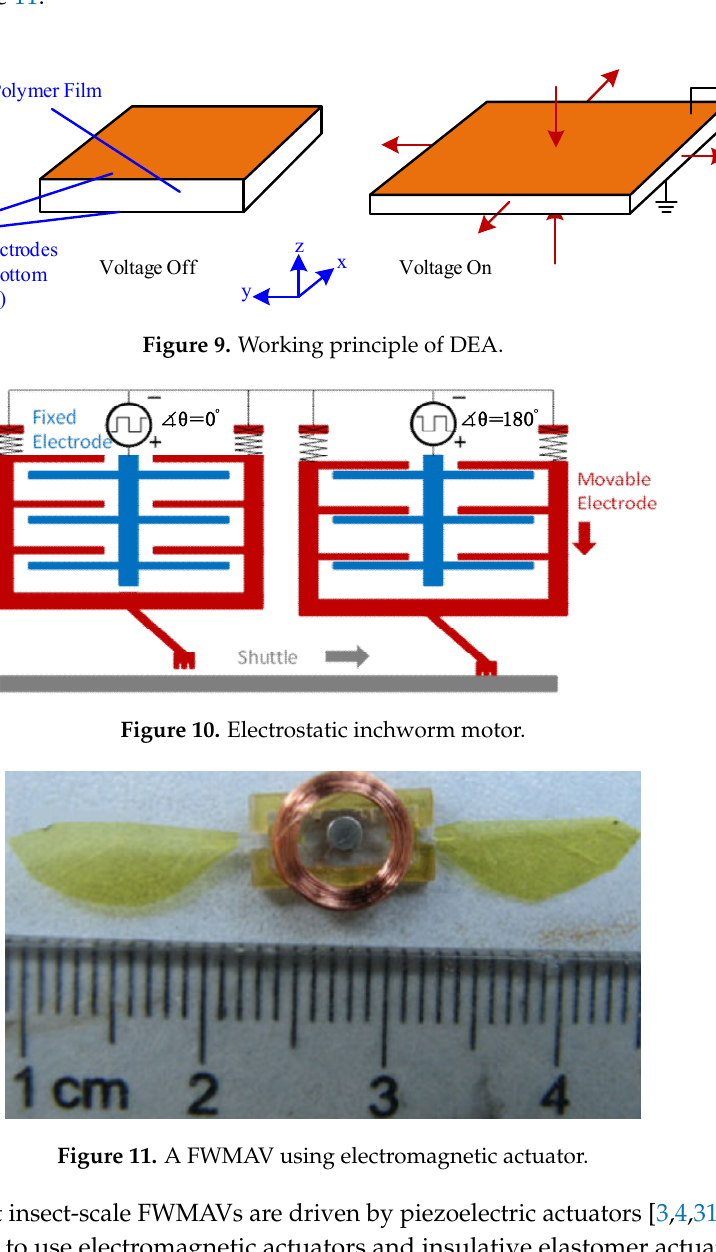
Figure 11. A FWMAV using electromagnetic actuator.